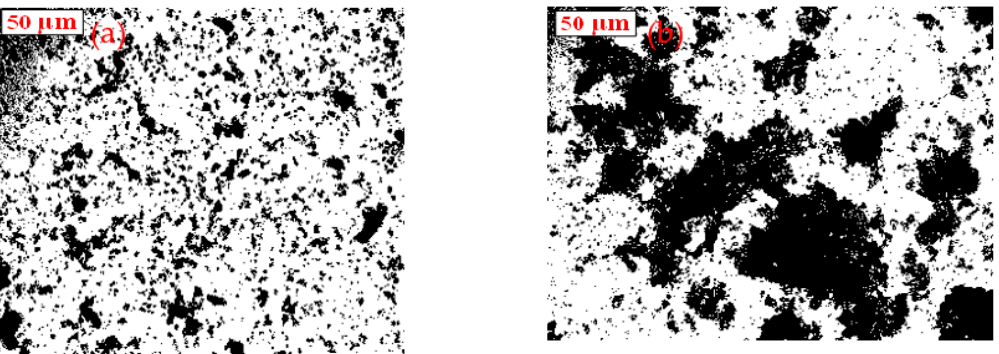
Figure 9. Optical microscope image of − 23 μ m cassiterite in the presence of BHA ( a ) and 5 × 10 − 5 mol/L NaOL after stirring at 900 r/min for 60 min ( b ).